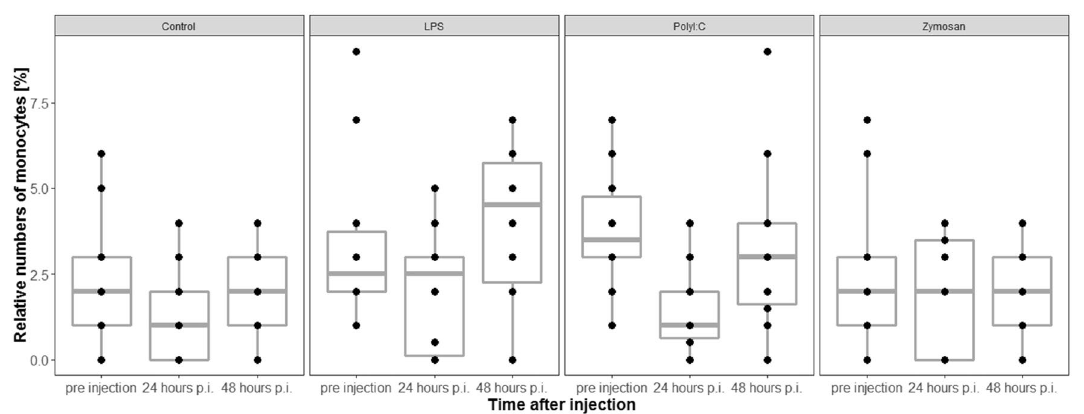
Figure 8. Relative numbers of monocytes were not associated with antigen type. p.i. = post injection. The figures show medians (bold line), 25–75% percentiles (box), maxima and minima (whiskers) and data points